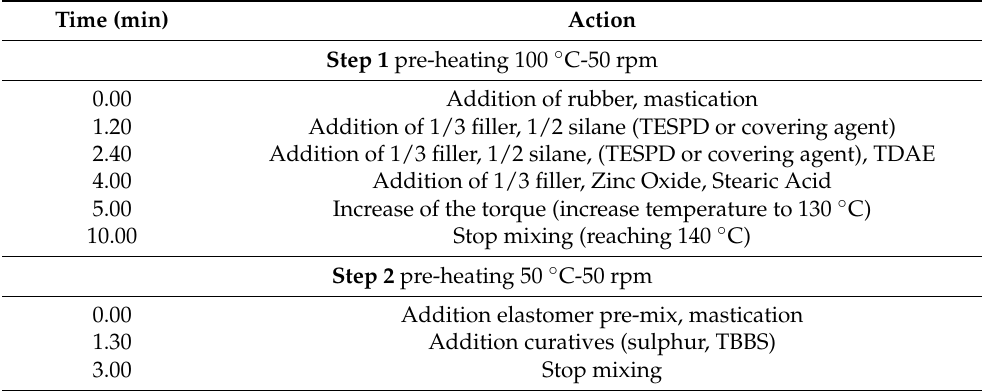
Table 2. Mixing procedure of the rubber